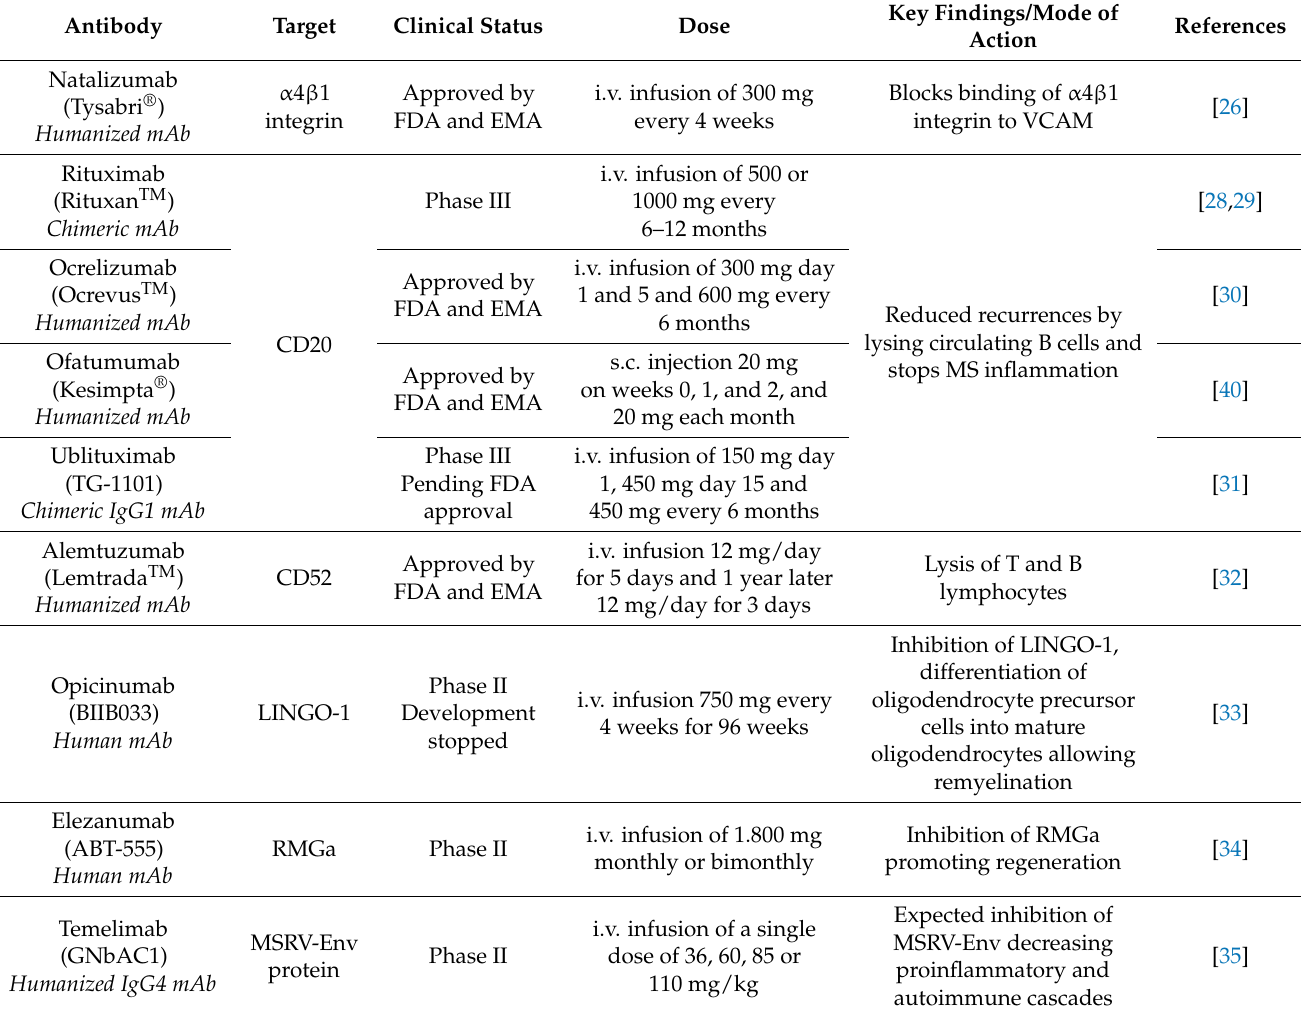
Table 1. Selected examples of antibodies used for multiple sclerosis. i.v., intravenous; s.c.,